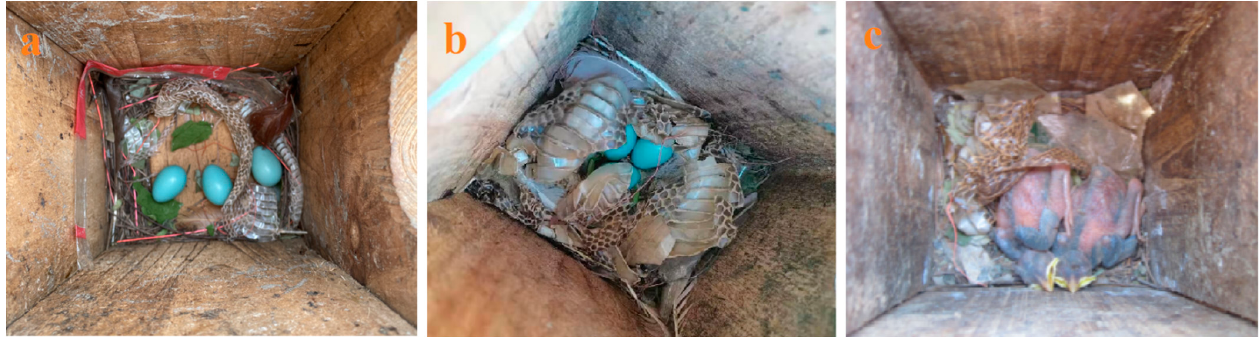
Figure 2. Snake sloughs in nests of crested mynas during the breeding season (( a ) the egg laying stage; ( b ) the incubation stage; ( c ) the nestling stage).